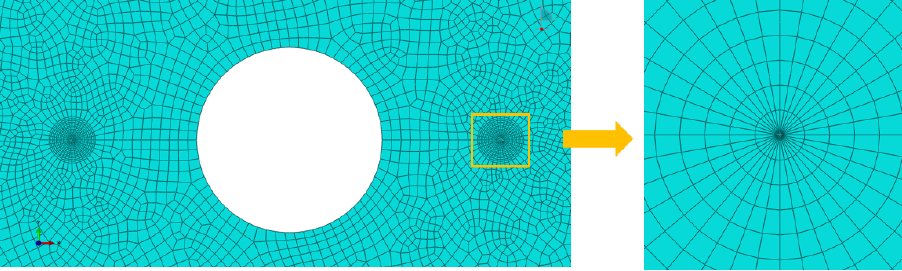
Figure 6. Meshing of crack tip.